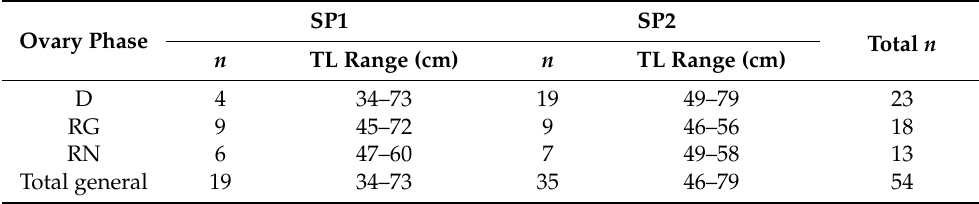
Table 1. Number of sampled females ( n ) in developing (D), regressing (RG), and regenerating (RN) for the daily growth analysis considering the two first spawning peaks (SP1, SP2) and the total length range (TL range, cm).